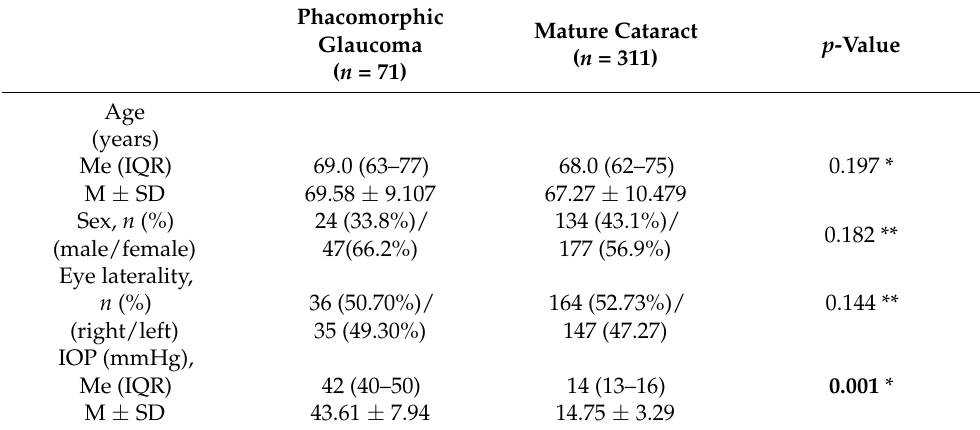
Table 1. Demographic and clinical features of the study